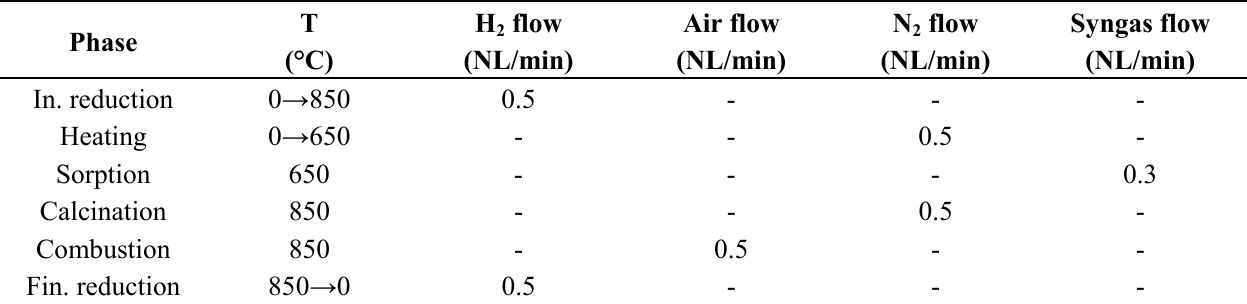
Table 5. Summary of the operative temperatures and gas flows for all test phases.